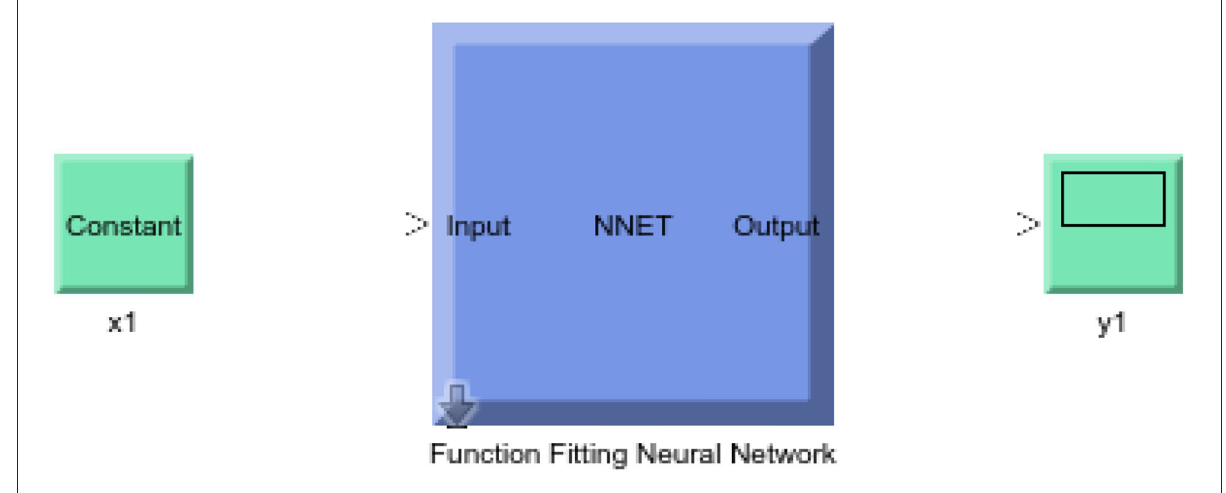
FIGURE6 Obtained Simulink by Levenberg-Marquardt